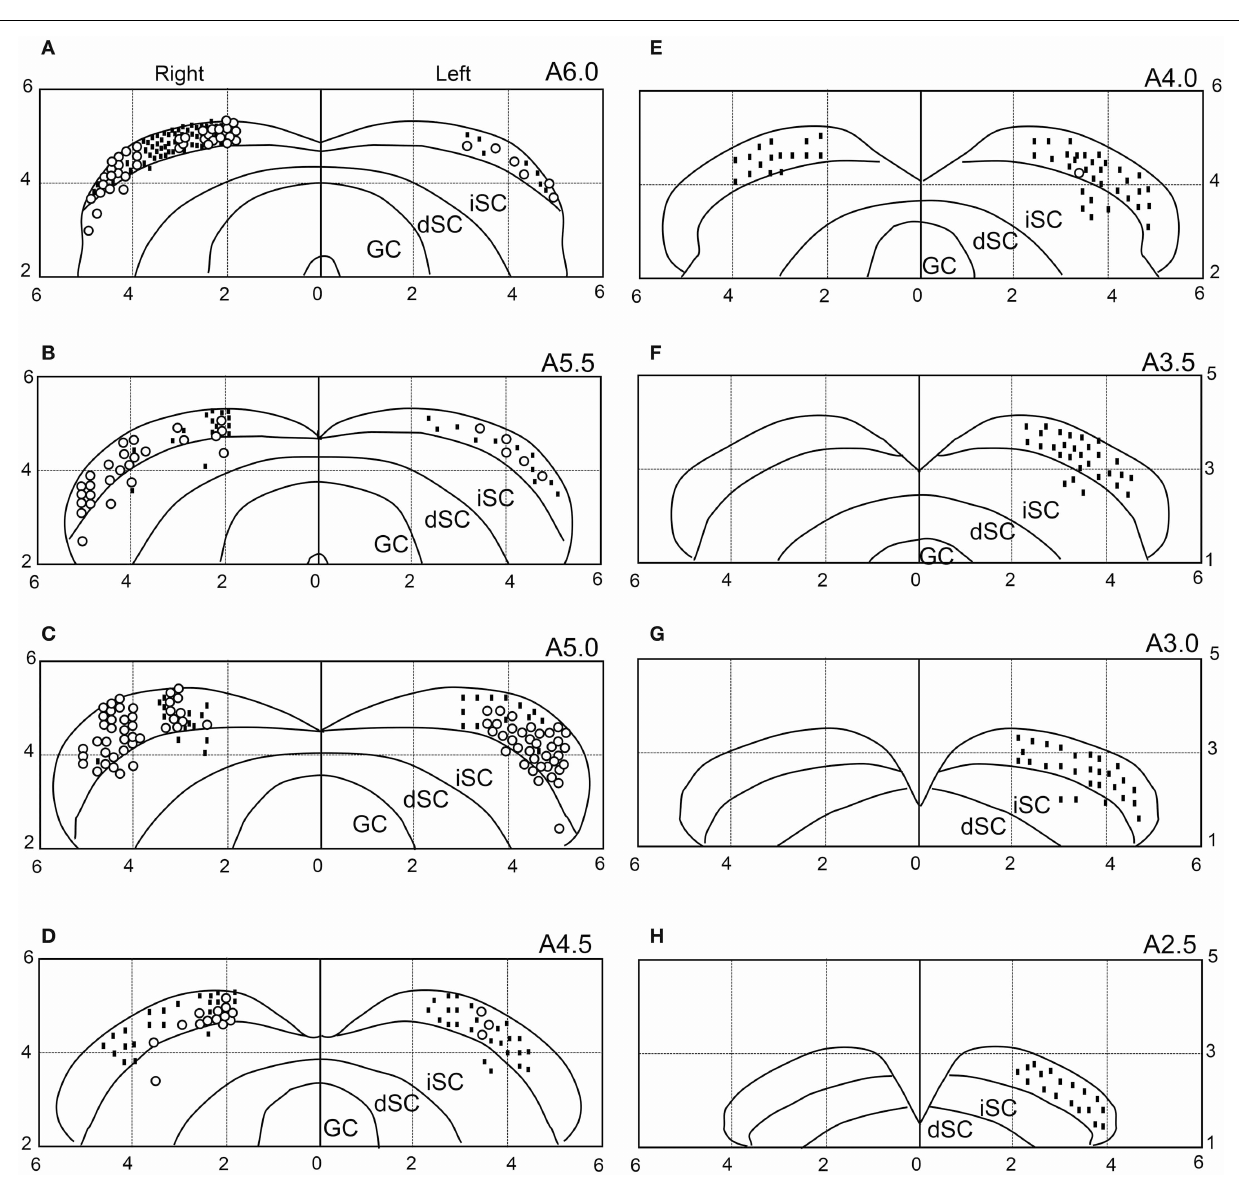
non-responsive neurons. Because some symbols are superimposed, the total number of symbols is smaller than the total number of SC neurons ( n = 646). iSC, intermediate layers of SC; dSC, deep layers of SC; GC, substantia grisea centralis. (A–H) Eight sections from the anterior to posterior